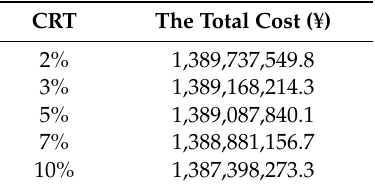
Table 12. Total cost based on di ff erent CRTs.